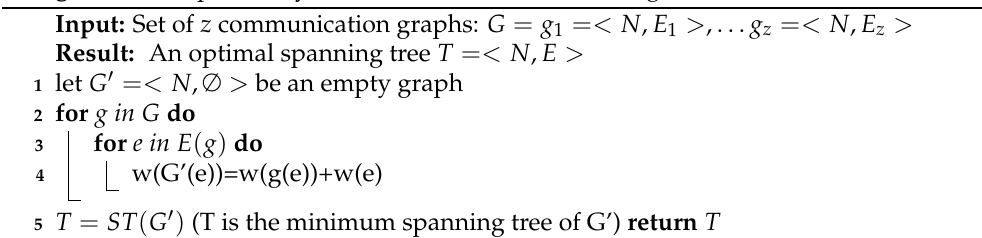
Algorithm 1: Optimal Dynamic Communication Tree